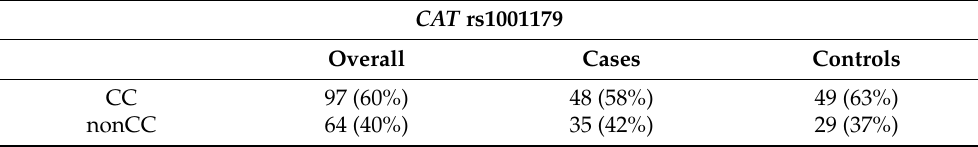
Table A1. Numbers of CRC cases and healthy controls depending on CAT gene polymorphism only.